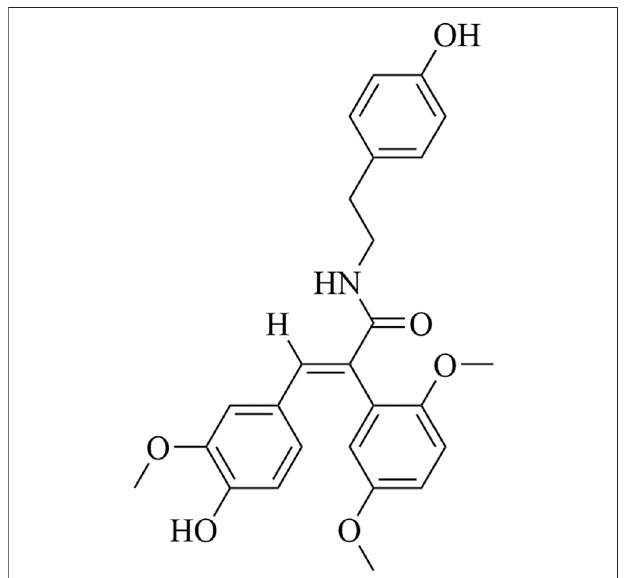
FIGURE 1 | Chemical structure of